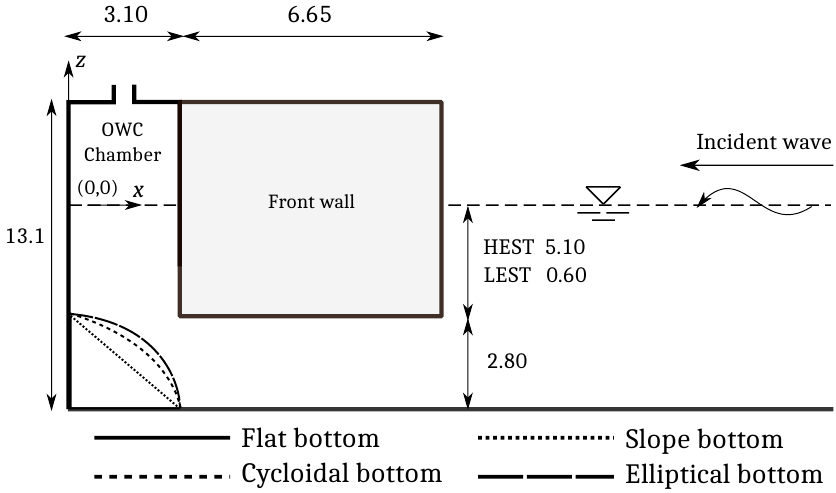
Figure 11. Definition sketch of a single chamber in the Mutriku Wave Energy Plant (Dimensions in meters. Chamber width = 4.5 m; HEST = Highest equinoctial spring tide and LEST = Lowest equinoctial spring